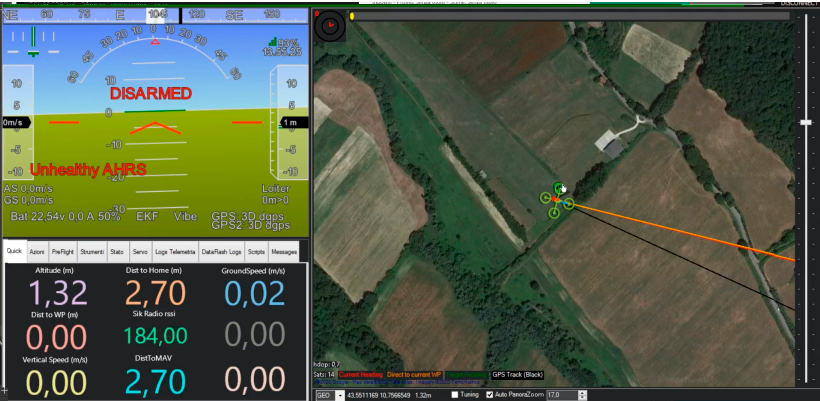
Figure 5. Drone data after a landing managed by Smart Capsule AI (note: comma is by used in this figure instead of dot for decimal separation)..